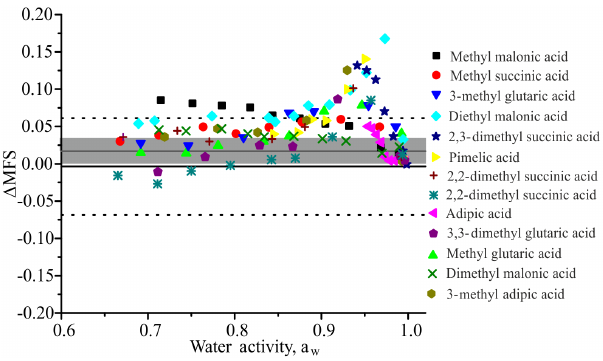
Figure 4. The difference between the mass fraction of solute from UNIFAC predictions and the CK-EDB data from this study ( (cid:49) MFS) for all 13 branched dicarboxylic acids studied. The average in (cid:49) MFS for the four dicarboxylic acids in Fig. 3 (CK-EDB data, this study) across the whole water activity range is represented with a shaded grey area, the average represented by the dark grey line. Ad- ditionally, the average (cid:49) MFS (solid black line) and standard devi- ation (dashed black lines) derived from the Peng et al. (2001) data are also shown in Fig. 3.